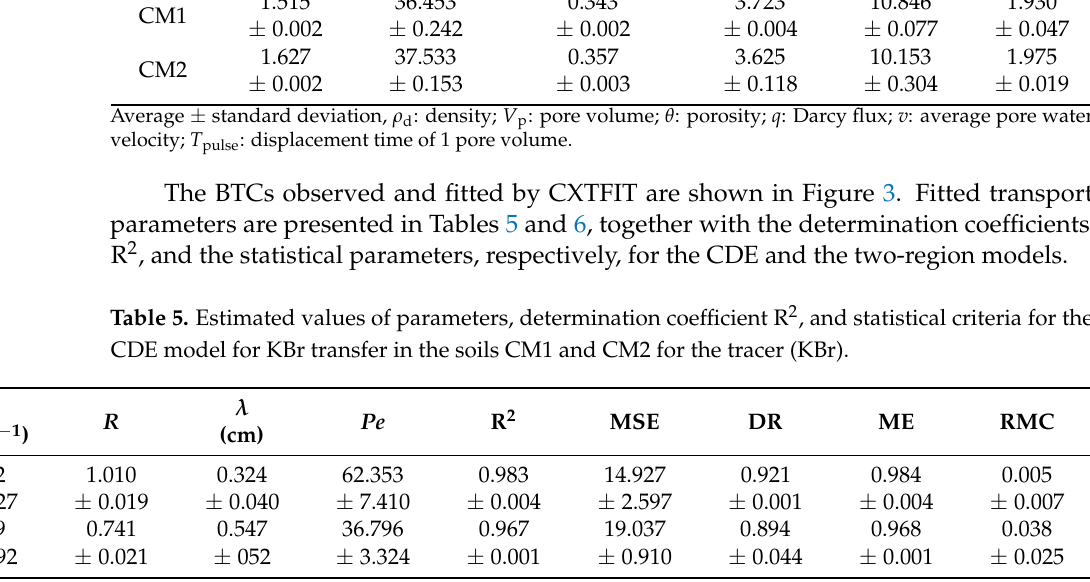
Table 4. Experimental conditions for the miscible displacement tests for CM1 and CM2. Layer